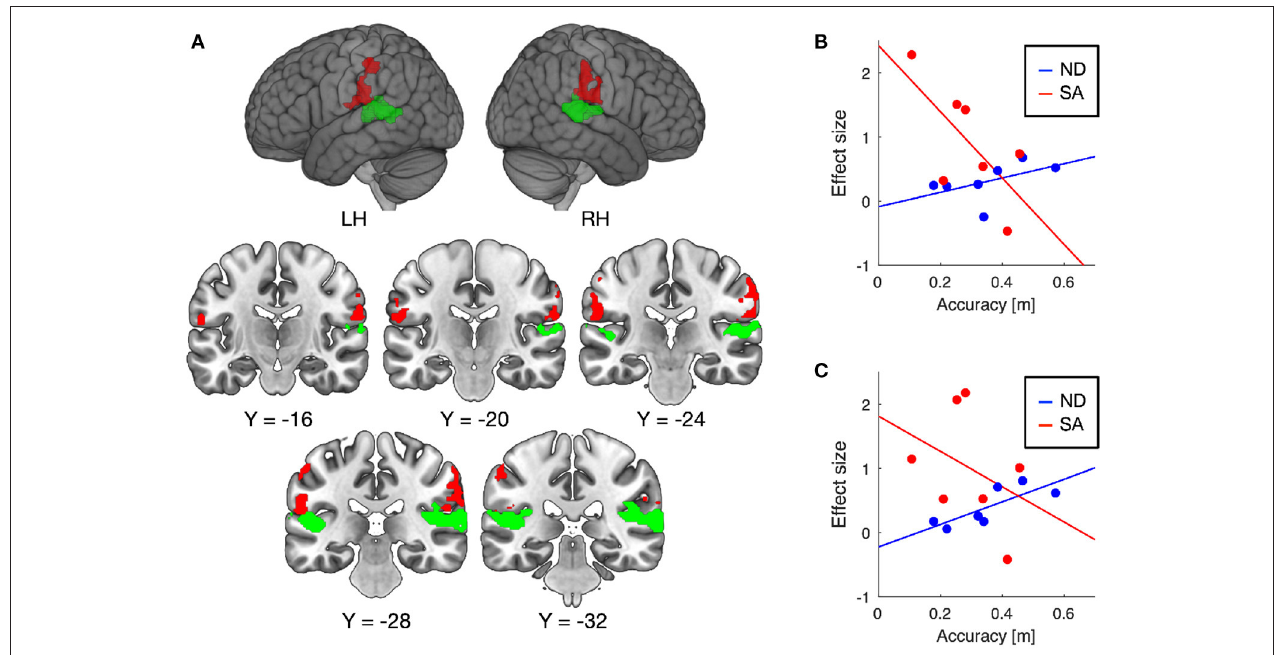
FIGURE 4 | Brain regions showing increased auditory responses after lane-keeping training under SA condition (pretest < posttest) (A) . Significant clusters (FWE-corrected P < 0.01) were found in the somatosensory areas bilaterally (red), which were not overlapped with the superior temporal auditory areas (green) revealed by the conjunction analysis (i.e., pretest ∩ posttest ∩ follow-up). In both clusters, increased activation after the training was negatively correlated with lane-keeping accuracy under SA condition, but positively under ND condition ( B , left cluster; C , right